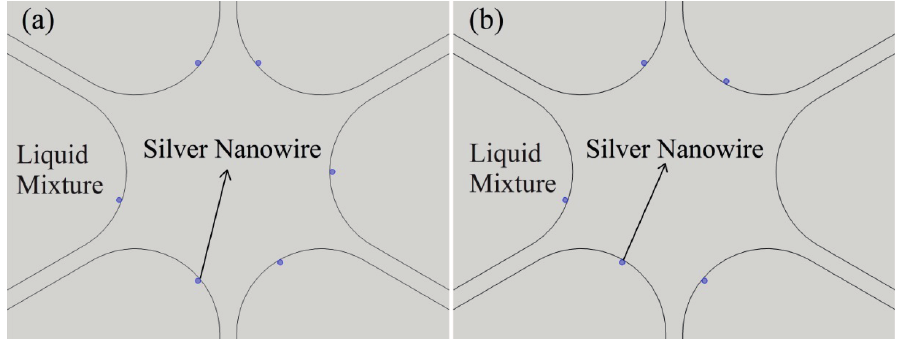
Figure 6. ( a ) Each of the fiber holes is randomly filled with one silver nanowire; ( b ) One of the holes is missed during the filling. The silver nanowires are indicated by blue dots.